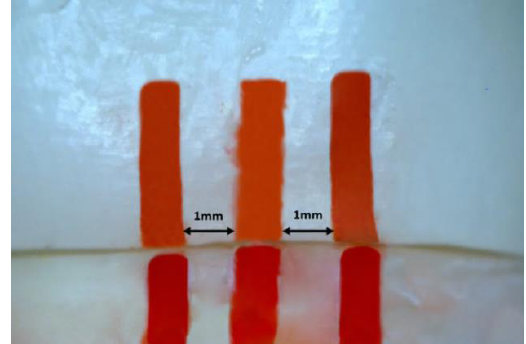
Figure 5: Points of measurement.